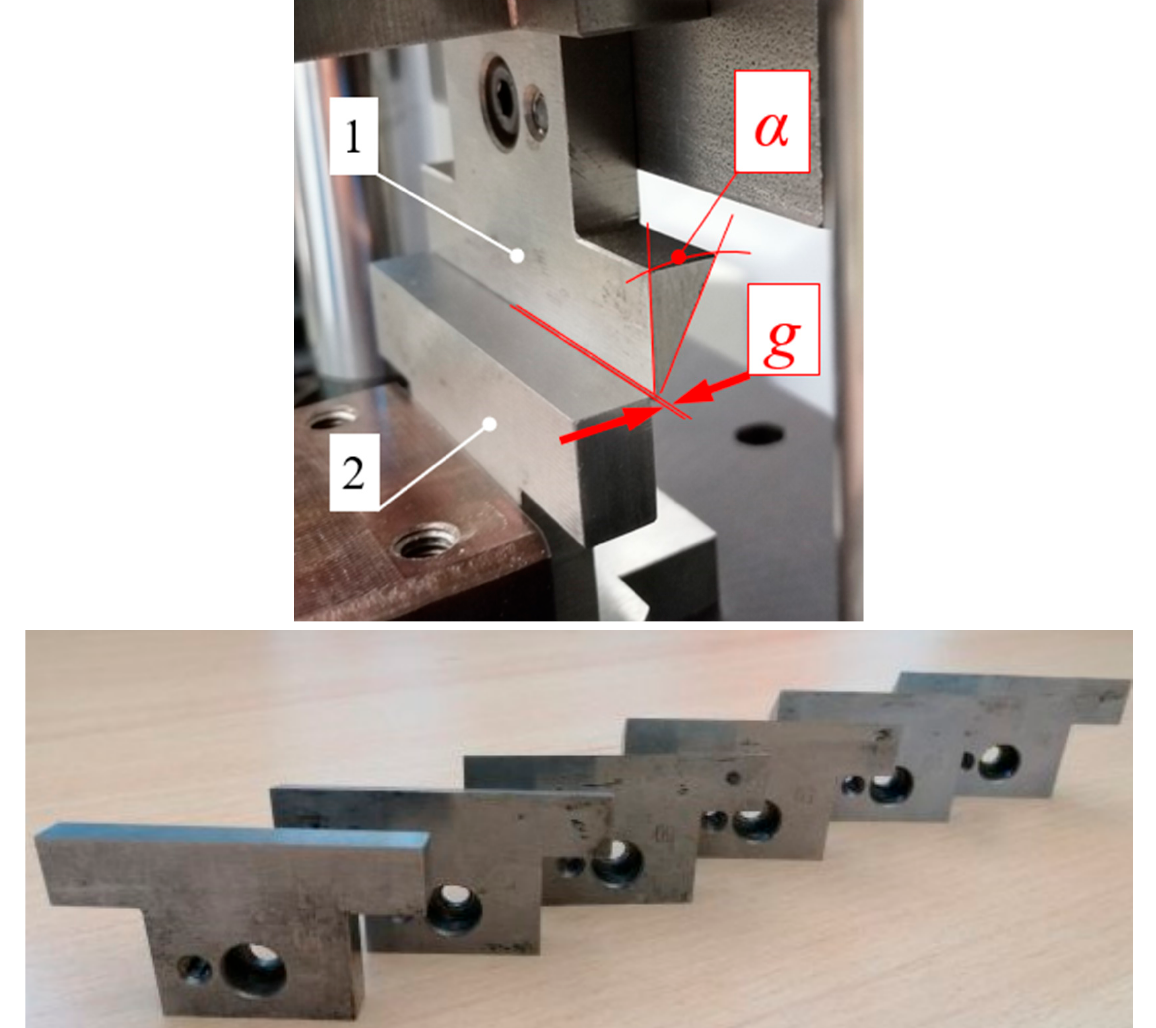
Figure 3. General view of the blade angle, α , and the distance g between the blade, 1, and the counter-blade, 2, of the testing station employed for cutting the corn stalks, with a general view of the blades employed in the study with the range of the blade-angle value α = 30–80 °.